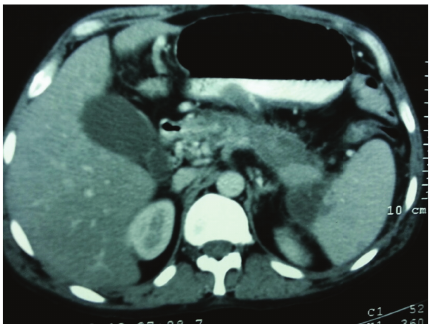
Figure 3: CT scan of the abdomen showing a pancreatic tail mass.